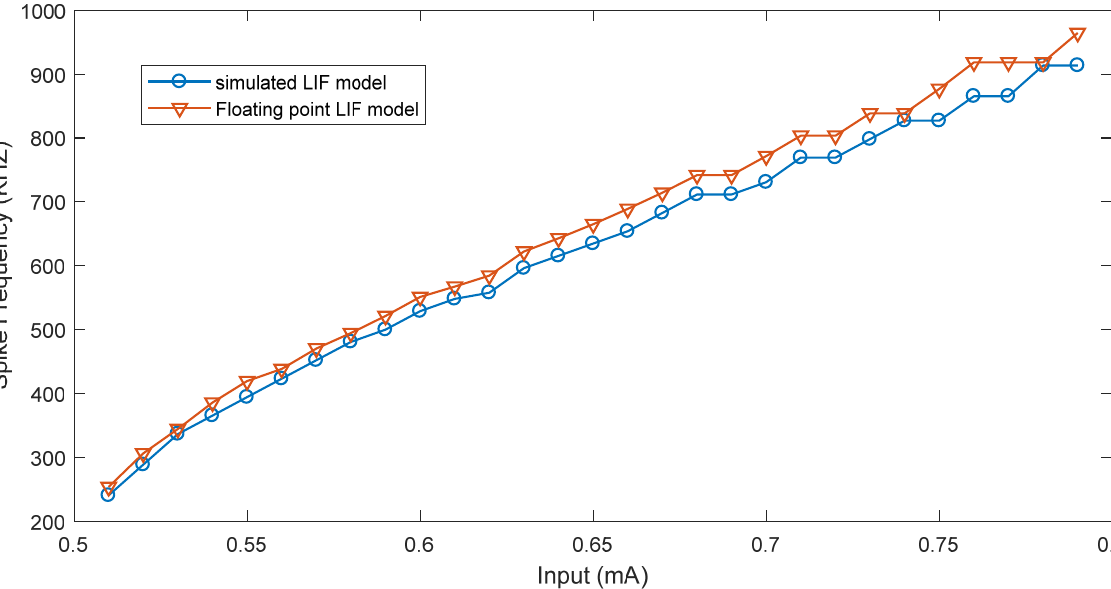
Figure 8. Spike rates of the implemented floating-point LIF neuron vs. simulation result.